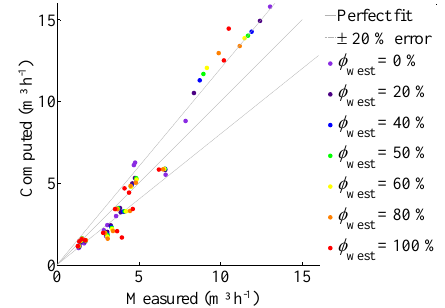
Figure 14. Computed vs. observed outflow discharges in each street for different partitions of the inflow discharge between the west and north